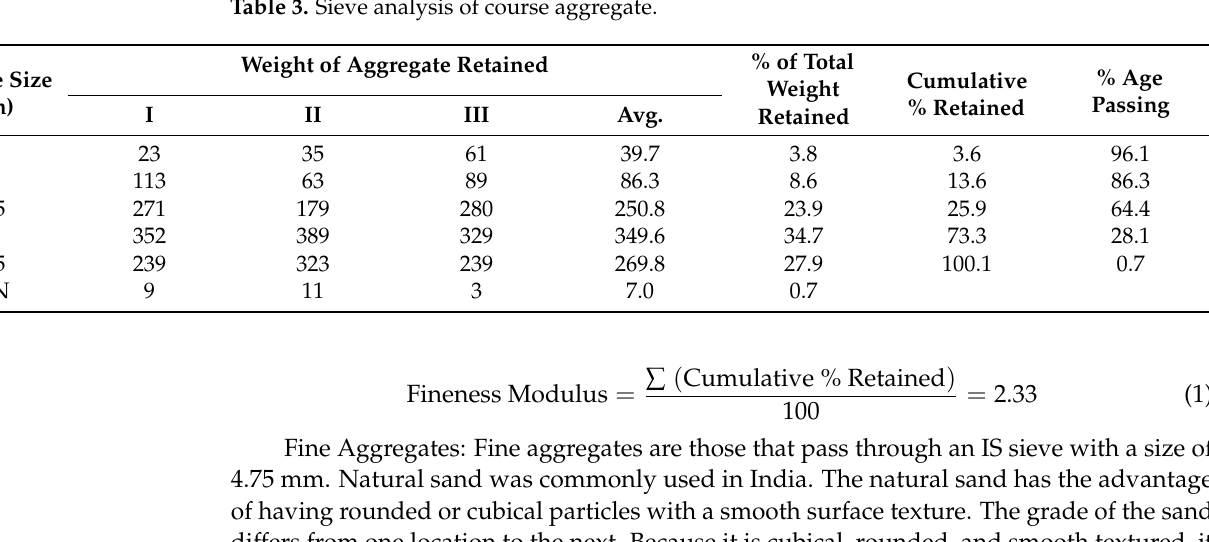
Table 3. Sieve analysis of course aggregate.